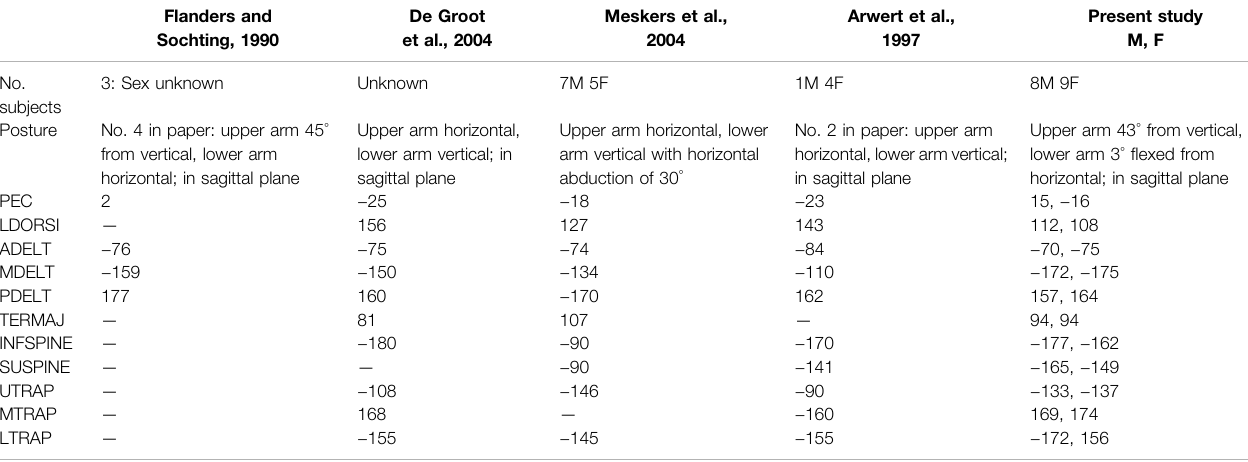
TABLE3| Comparisonofliterature-reportedprincipaldirectionvs.thepreferreddirectionsreportedinthepresentstudy.Thesepreviousstudiesreporttheprincipaldirection from their cosine function or second order polynomial fi t to their data rather than the preferred direction calculated directly from the STP used in the present study. Note that the data has been transformed 180 ° from reported values to match the convention of direction corresponding to the loading direction, rather than the direction of force generated. All data reported in units of ( ° ) with 0 ° in abduction, 90 ° fl exion, 180 ° adduction, − 90 ° extension. The present study presents the preferred direction for the males and females